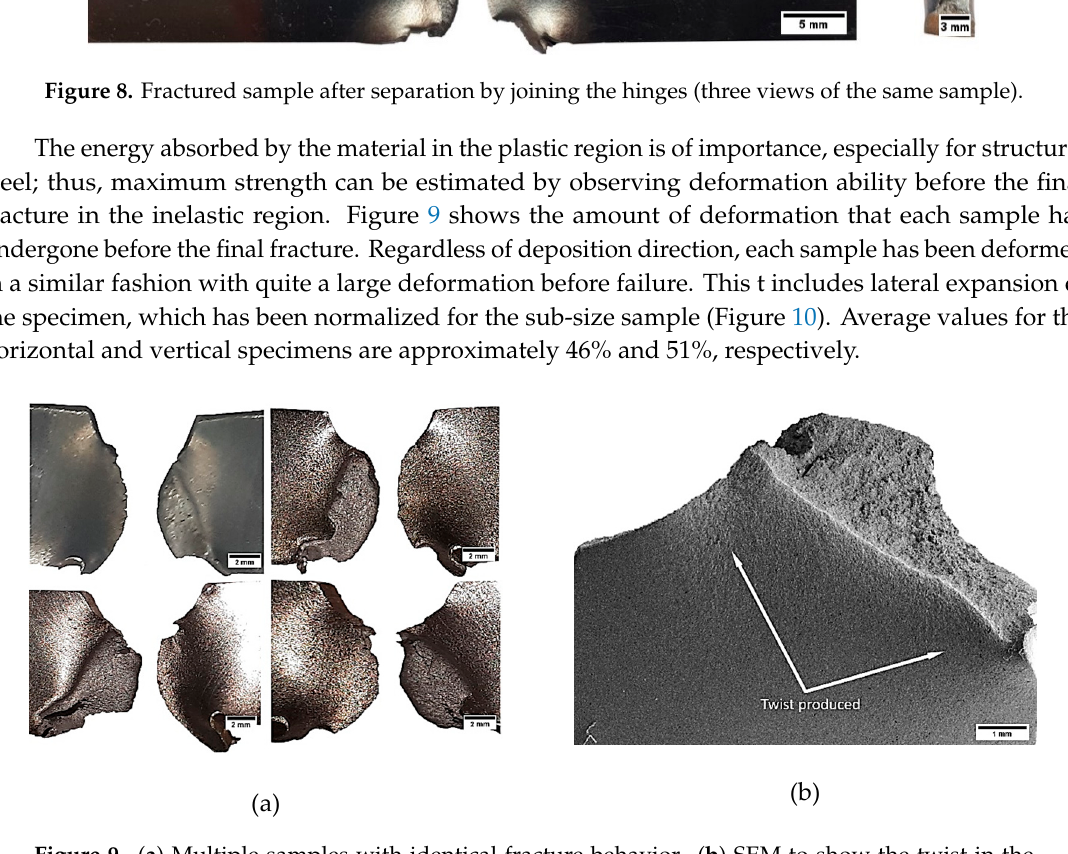
Figure 9. ( a ) Multiple samples with identical fracture behavior. ( b ) SEM to show the twist in the deformed sample.